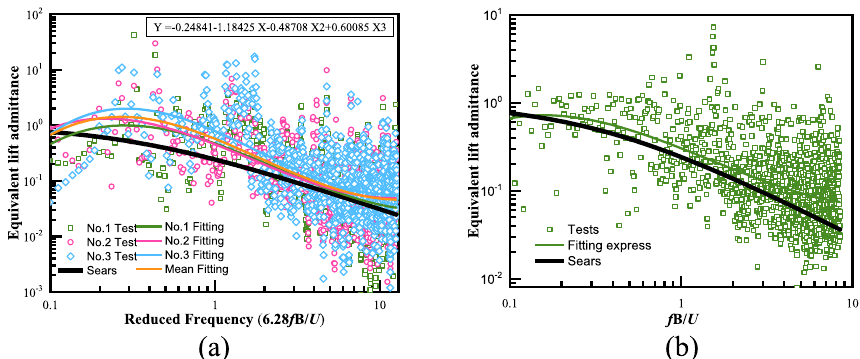
Fig. 11 Results of comparison between different methods of admittance recognition for streamlined box girder model under different integral scale (0° AOA, 11.5% turbulence intensity, and 5.3 m/s wind speed). a Recognition result of equivalent lift admittance function ( L x u = 3.0 m). b Recognition result of equivalent lift admittance function ( L x u = 3.0